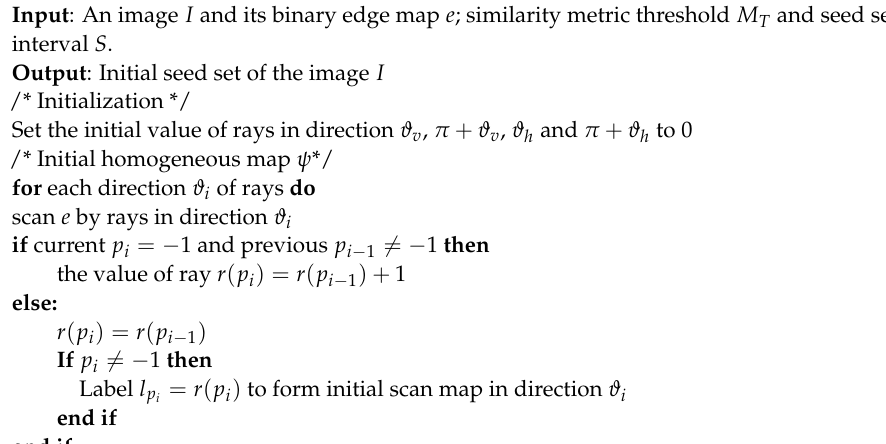
Algorithm 1. Adaptive seed sampling strategy.